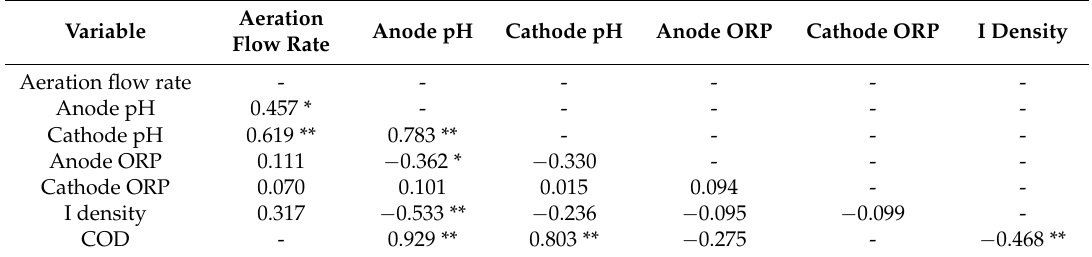
Table 1. Correlation analysis for the MFC performance.